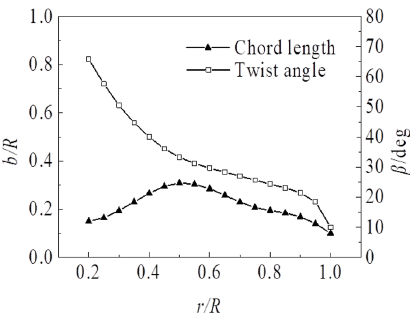
Figure 4. Propeller chord and twist angle.